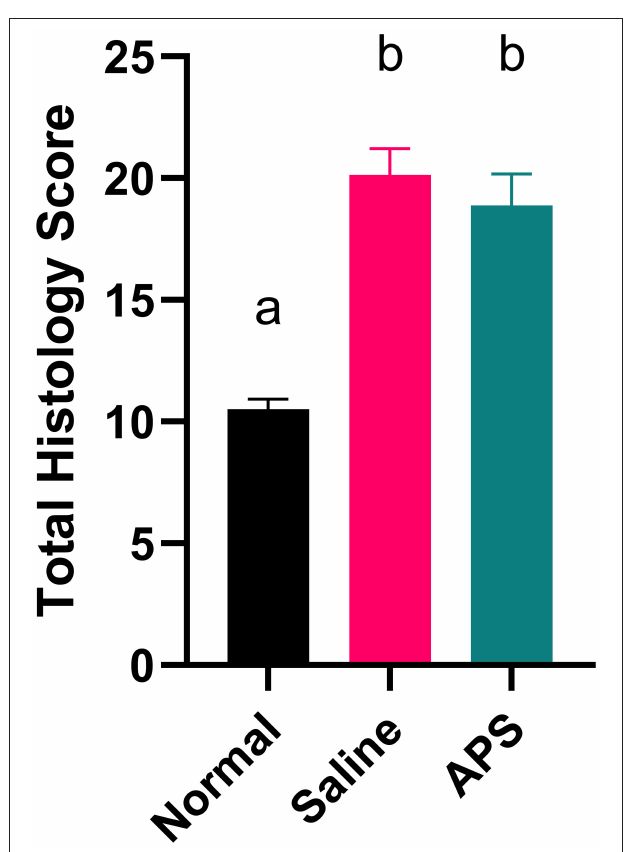
FIGURE 5 | Total histologic score (mean ± SEM) at 16cm DACB 12-weeks following intra-lesional injection of saline or APS. Total histologic scores for normal tendon are included for reference. Total scores represent the sum of histologic scores for tenocyte linearity, tenocyte density, hemorrhage, neovascularization, perivascular cuffing, collagen fiber linearity, collagen fiber uniformity, epitenon thickening and polarized light crimping. Different letters denote significant differences between groups, p less than or equal to 0.05 ( n =